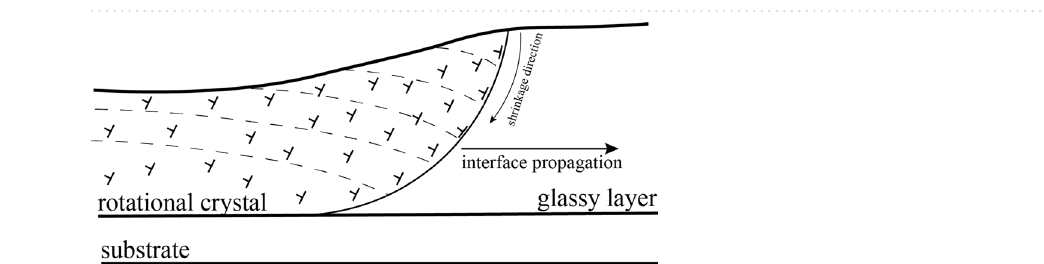
Figure 4. Crystalline/Amorphous (C/A) interface profile studied by AFM. ( a ) Top view of spherulite/ amorphous coating interface. ( b ) The same area shown in 3D view. ( c ) Height profile along the arrow shown in ( a ). Height averaged over 9 lines close and parallel to the arrow.